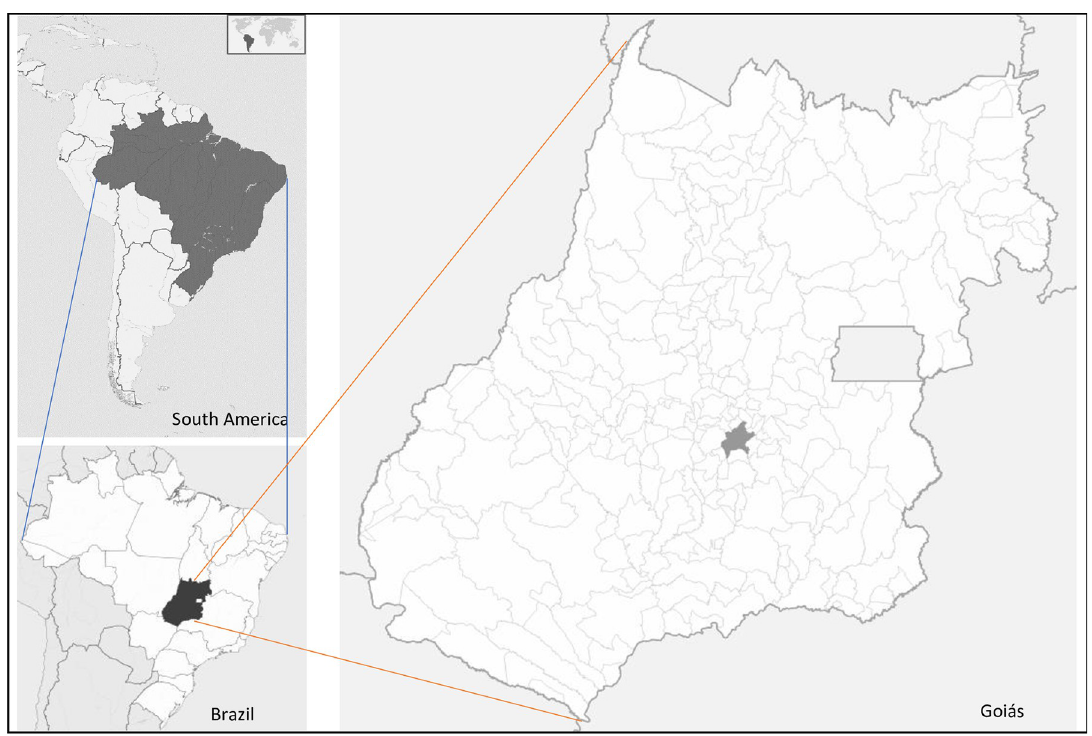
Fig 1. Location map of the State of Goias and the city of Goiania in Brazil, Brazilian Institute of Geography and Statistics (IBGE), 2022 https://portaldemapas.ibge.gov.br/portal.php#homepage).